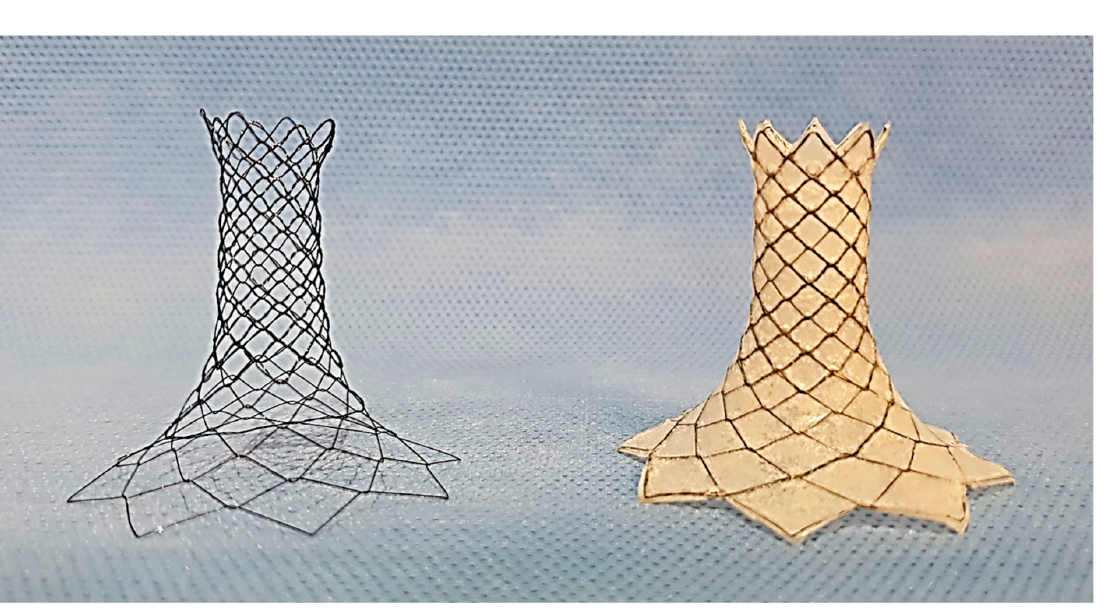
Figure 1. Photograph showing self-expandable retainers (SERs). Left: bare type of SER. Right: fully covered type of SER.